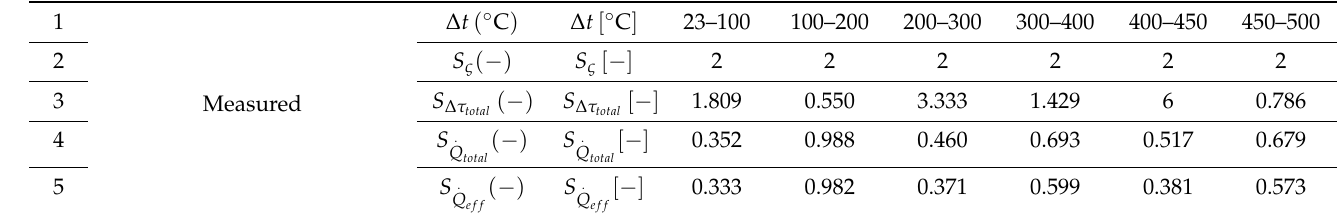
Table A10. The 1:4/1:2 unpainted